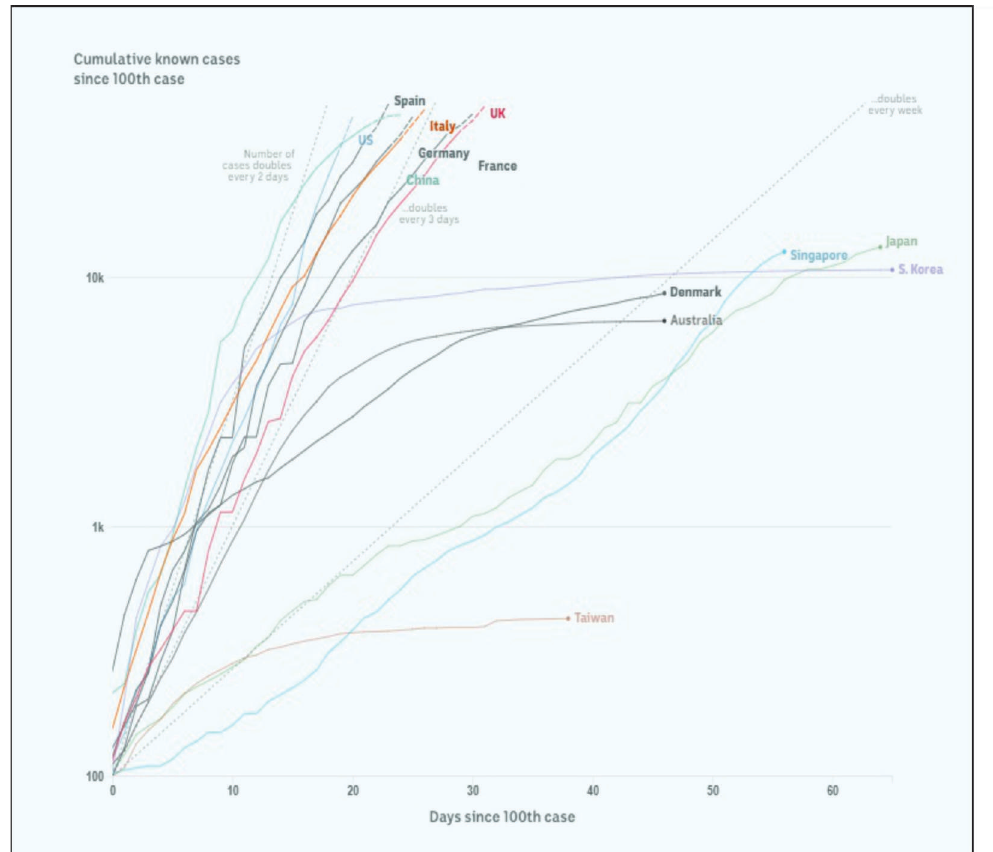
Figure 1: Distribution of the caseload after 100 cases of selected countries